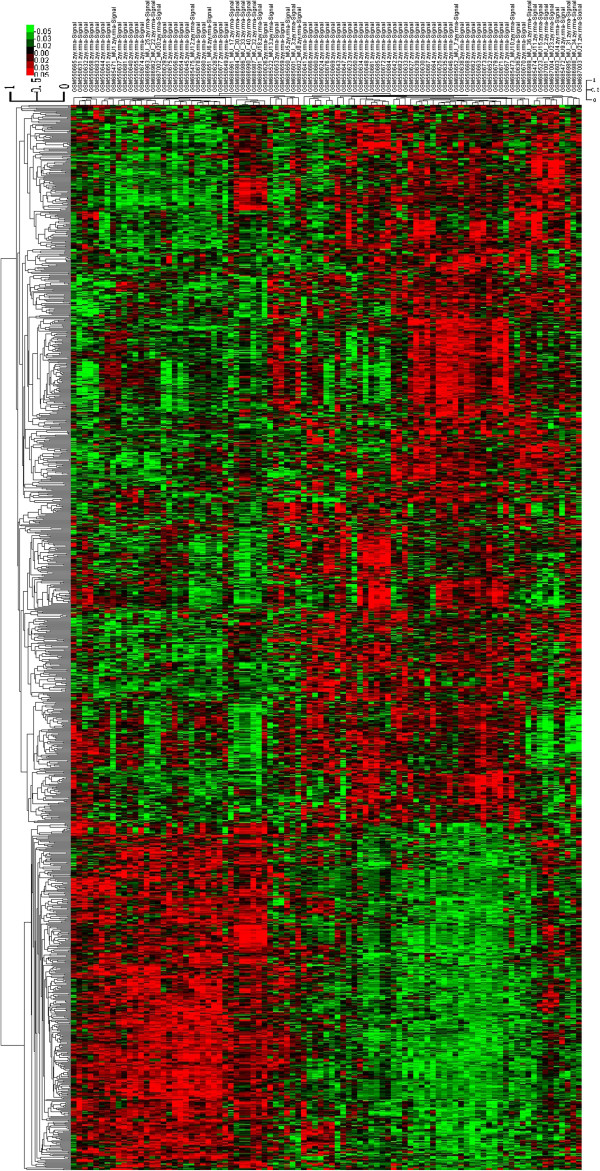
Unsupervised classification of uveal melanoma samples based on gene expression profiling. Classification of 91 uveal melanoma samples using the 1138-probe sets identified as differentially expressed between the 46 liver metastatic samples and the 45 non-metastatic samples. Expression data are depicted as a data matrix where each row represents a gene and each column represents a sample. Expression levels are depicted according to the color scale shown at the top. Red and green indicate expression levels, respectively, above and below the median. The magnitude of deviation from the median is represented by the color saturation.